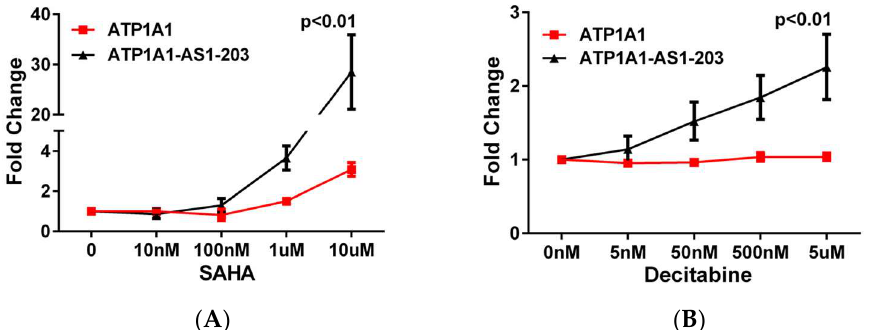
Figure 3. Epigenetic regulation of ATP1A1-AS1 expression in HK2 cells. Cultured HK2 cells were treated with deacetylase inhibitor, suberoylanilide hydroxamic acid (SAHA) ( A ) or DNA methylation inhibitor Decitabine ( B ) for 48 h and the total RNA was extracted using a commercial RNA extraction kit as described in Method section. The expression of ATP1A1-AS1-203 and ATP1A1 was measured using RT-qPCR. These experiments were repeated four times. Data was analyzed using Two-way ANOVA.